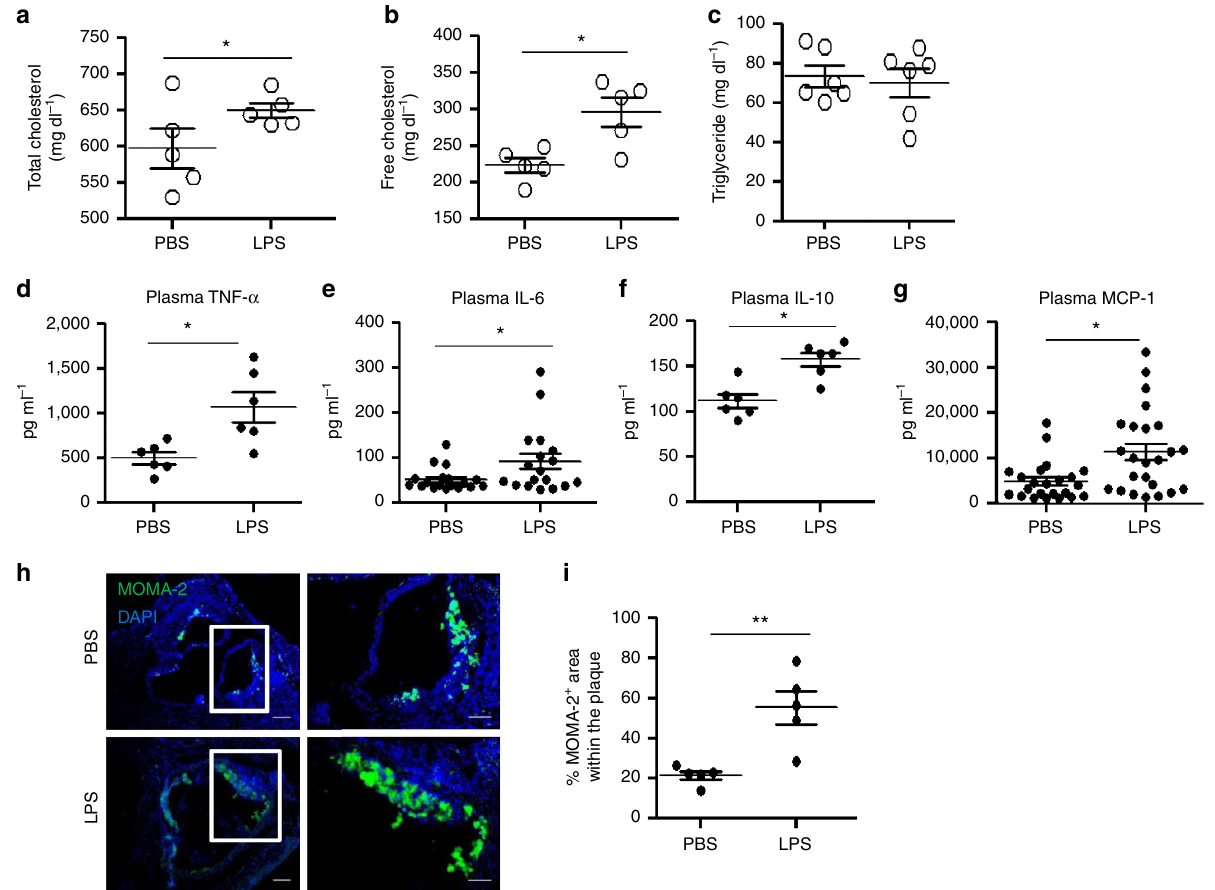
Figure 2 | Subclinical endotoxemia induces low-grade inflammation in vivo . ApoE (cid:2) / (cid:2) mice were pre-conditioned with PBS or super-low-dose LPS for 4 weeks together with HFD, followed by HFD feeding only for an additional 4 weeks. The levels of total ( a ) and free cholesterol ( b ) in the plasma were tested. Data are shown from PBS ( n ¼ 5) and super-low-dose LPS-conditioned ( n ¼ 5) mice. ( c ) Triglyceride levels in the plasma from PBS ( n ¼ 6) and super-low-dose LPS-conditioned ( n ¼ 6) mice. ( d ) Plasma tumour necrosis factor (TNF)- a levels from PBS ( n ¼ 6) and super-low-dose LPS-conditioned ( n ¼ 6) mice. ( e ) Plasma IL-6 levels from PBS ( n ¼ 18) and super-low-dose LPS-conditioned ( n ¼ 18) mice. ( f ) Plasma IL-10 levels from PBS ( n ¼ 5) and super-low-dose LPS-conditioned ( n ¼ 6) mice (left panel). ( g ) Plasma MCP-1 levels from PBS ( n ¼ 23) and super-low-dose LPS-conditioned ( n ¼ 24) mice (right panel). ( h ) Representative images of MOMA-2 þ macrophages in the atherosclerotic plaques of aortic root areas. Scale bar, left panel: 300 m m; right panel: 100 m m. ( i ) Quantification of MOMA-2 þ area as a percentage of the total atherosclerotic plaque area within the aortic root. Data are shown for aortic plaque areas from PBS ( n ¼ 5) and super-low-dose LPS-conditioned ( n ¼ 5) mice. Data are representative of two similar experiments. * P o 0.05 and ** P o 0.01; Student’s t